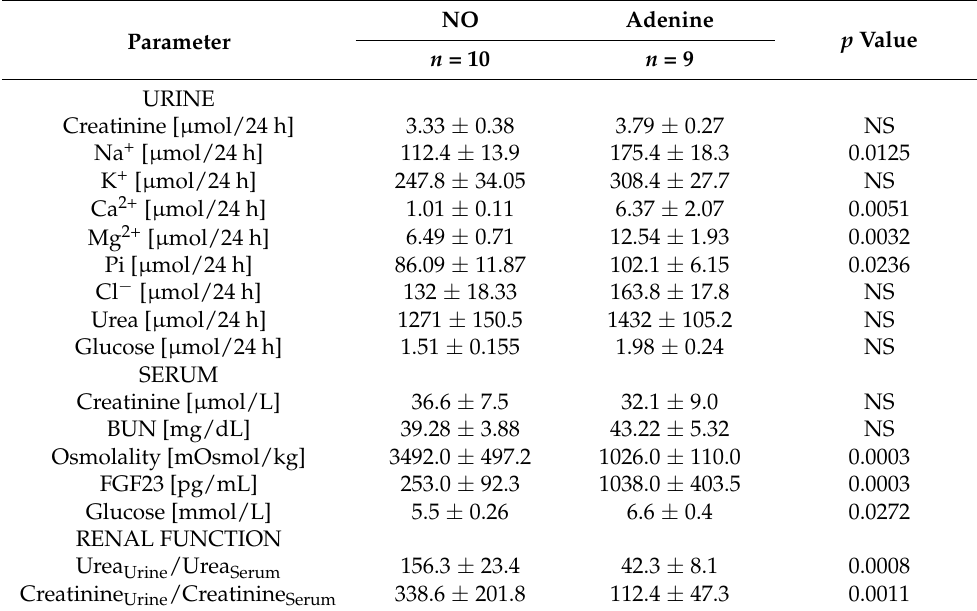
Table 1. Effect of Adenine on marker of CKD in urine and serum in ApoE KO mice.